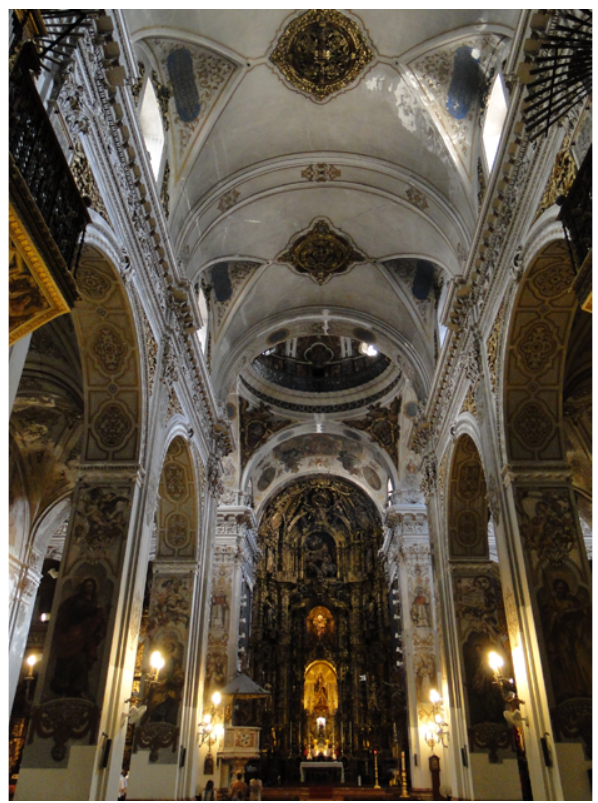
Figure 14: The interior of the church of the former con- vent of San Pablo el Real. View from the narthex towards the High Altar. Image from